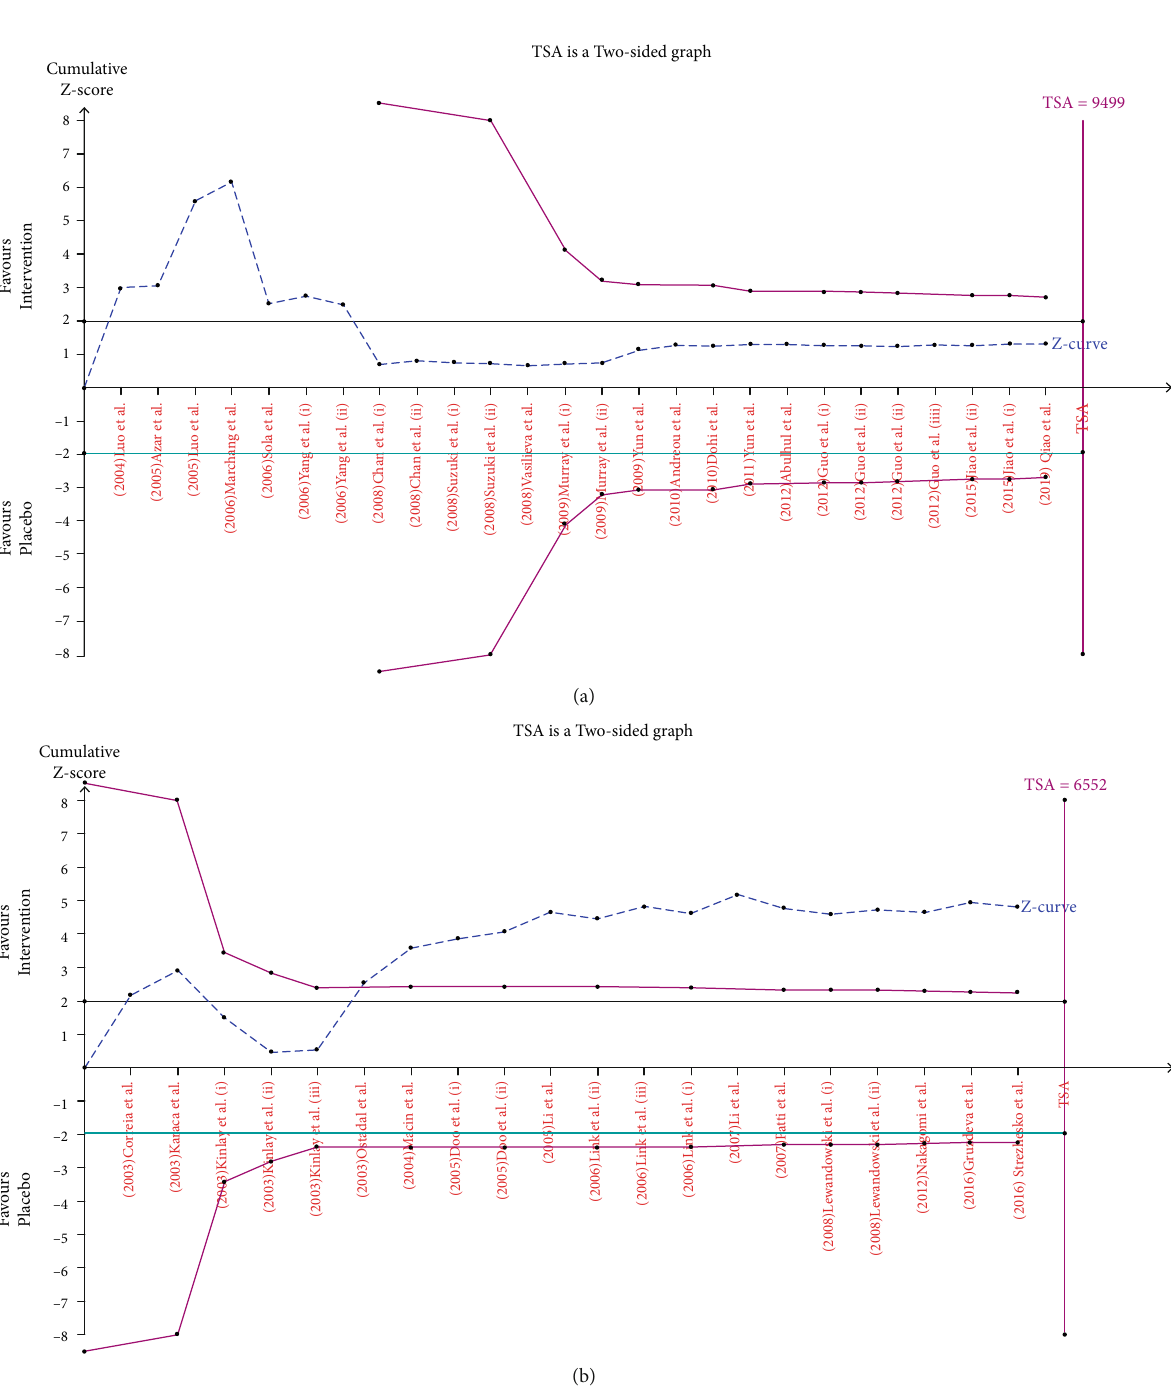
Figure 4: Trial sequence analysis of all the included studies for the e ff ect of statin administration on the serum levels of hs-CRP (a) and CRP (b). Cumulative Z -curve (dashed blue lines), conventional boundary (green horizontal lines), trial sequential monitoring boundaries (inward sloping purple line), and required information sizes (purple vertical